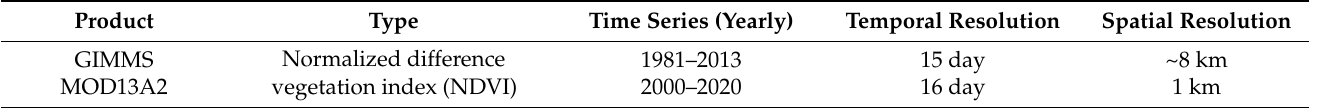
Table 1. GIMMS and MODIS data